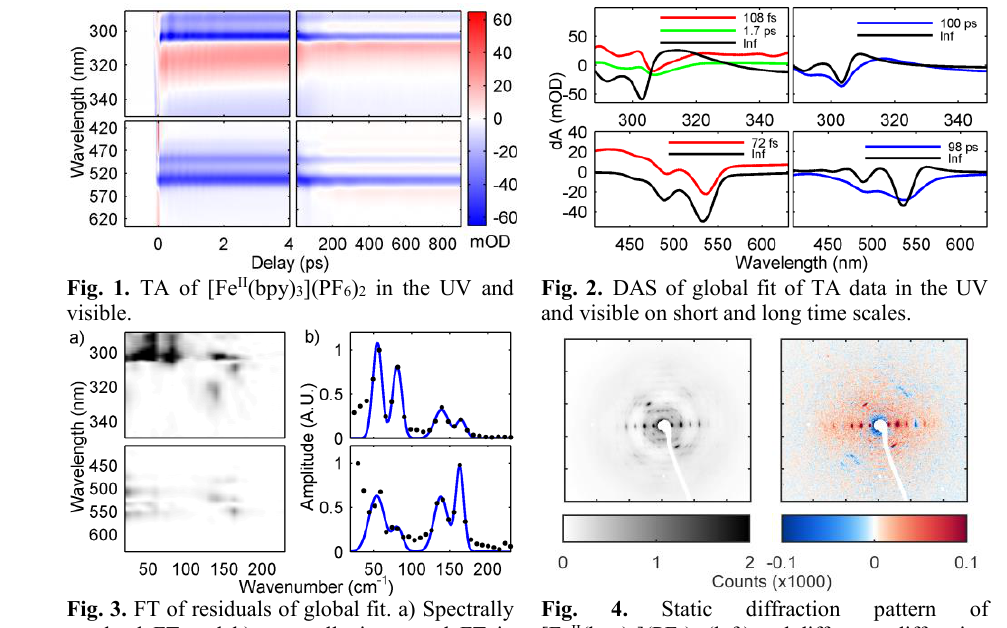
Fig. 3. FT of residuals of global fit. a) Spectrally resolved FT and b) spectrally integrated FT in UV and visible.